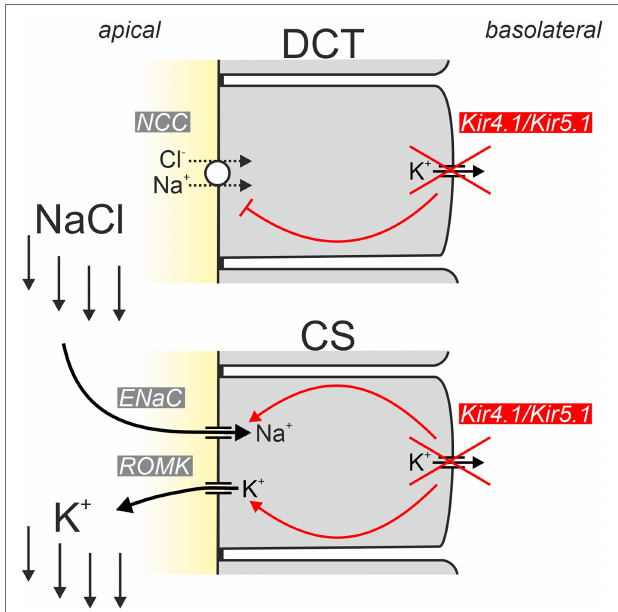
FIGURE 5 | Simplified model explaining the hypokalemic phenotype of EAST/SeSAME patients. Inactivation of basolateral Kir4.1 in the distal convoluted tubule (DCT) results in reduced potential-driven transport across the basolateral membrane and inhibition of apical NCC-mediated uptake of NaCl. As a consequence, increased amounts of NaCl enter the collecting system (CS), where Na + is taken up by ENaC and K + is secreted by ROMK channels leading to urinary K + loss. Inactivation of Kir4.1 in the CS worsens urinary K + loss since apical ENaC and ROMK activities are unleashed and the physiological inhibition ( via Kir4.1-dependent signaling) of both conductances under hypokalemic conditions is abrogated [modified from Penton et al.